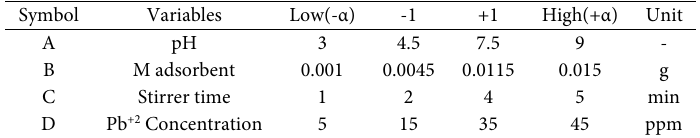
Fig. 2. Magnetic curves of the ( ____ ) Fe O @MCM-41 and (……) Fe 3 4 Fig. 2 Magnetic curves of the ( ____ ) Fe 3 O 4 @MCM-41 and (……) Fe 3 O 4 @MCM-41@NH 2 . Table 2 Independent variables and and their coded levels. Table 2. Independent variables and and their coded levels